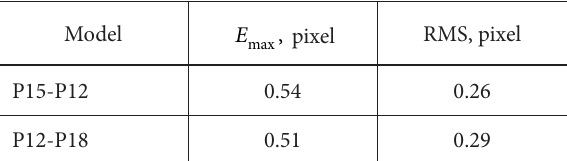
Table 3. Measurement quality at Tie and